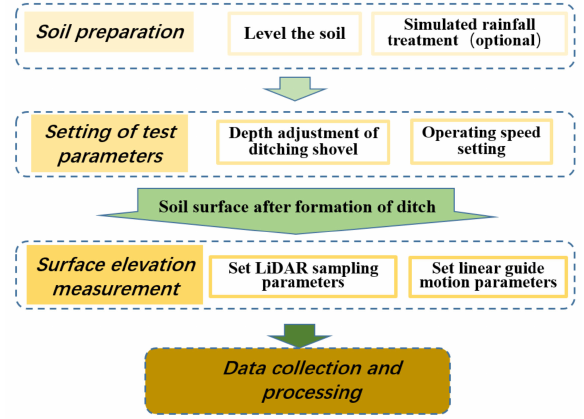
Figure 5. The test process and data collection